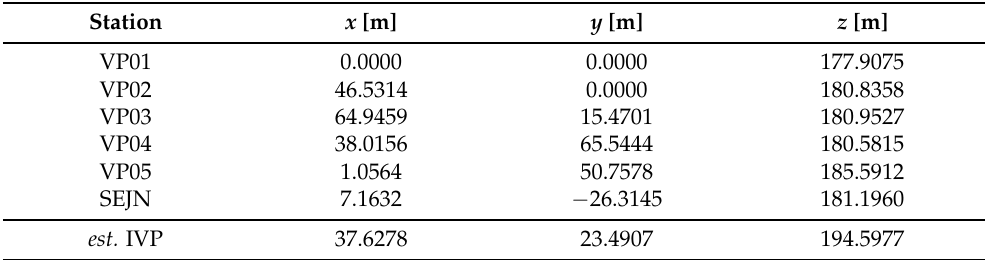
Table 1. Initial coordinates of each pillar/CORS along with the previous results of IVP estimation. Station x [m] y [m] z [m] VP01 0.0000 0.0000 177.9075 VP02